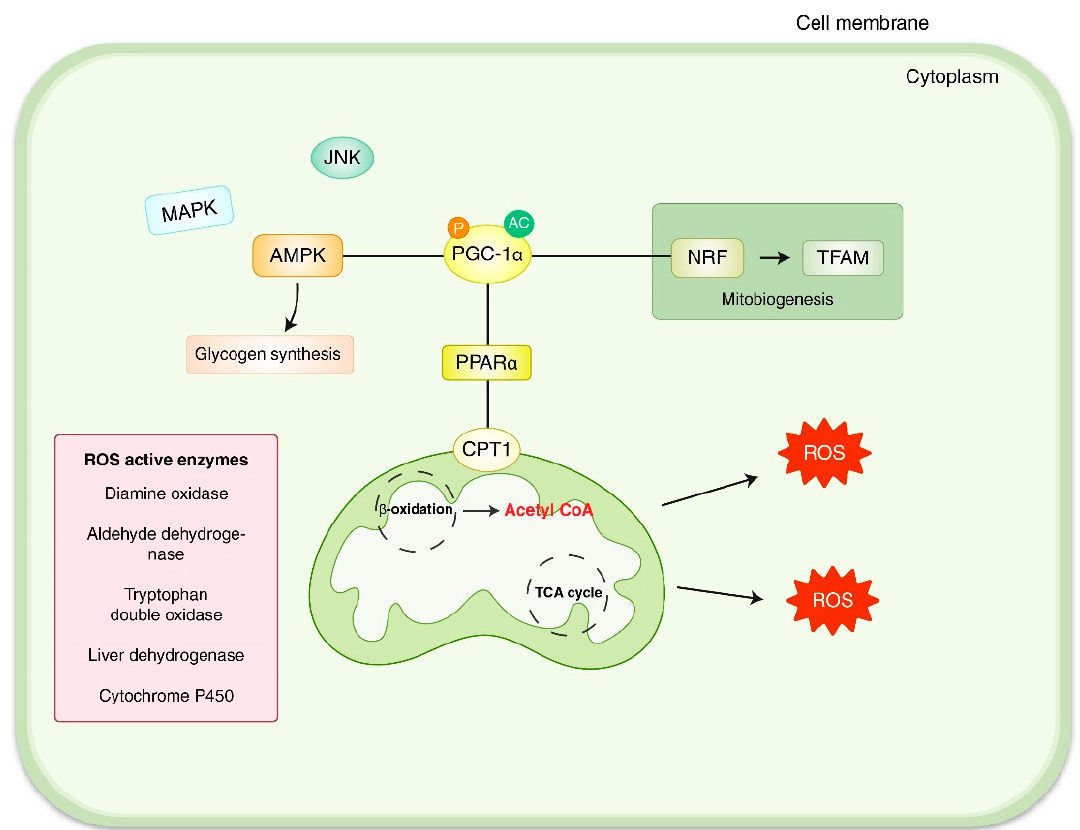
Figure 2. Role of mitochondrial dysfunction in ROS production. Mitogen-mediated protein kinases (MAPKs), adenosine monophosphate-mediated protein kinase (AMPK), Peroxisome proliferator- activated receptor gamma coactivator 1-alpha (PGC-1 α ), Peroxisome proliferator-activated receptor gamma (PPAR γ ), carnitine palmitoyltransferase-1 (CPT-1), c-Jun N-terminal kinase (JNK), nuclear factor erythroid 2-related factor 2 (Nrf2), mitochondrial transcription factor A (TFAM).